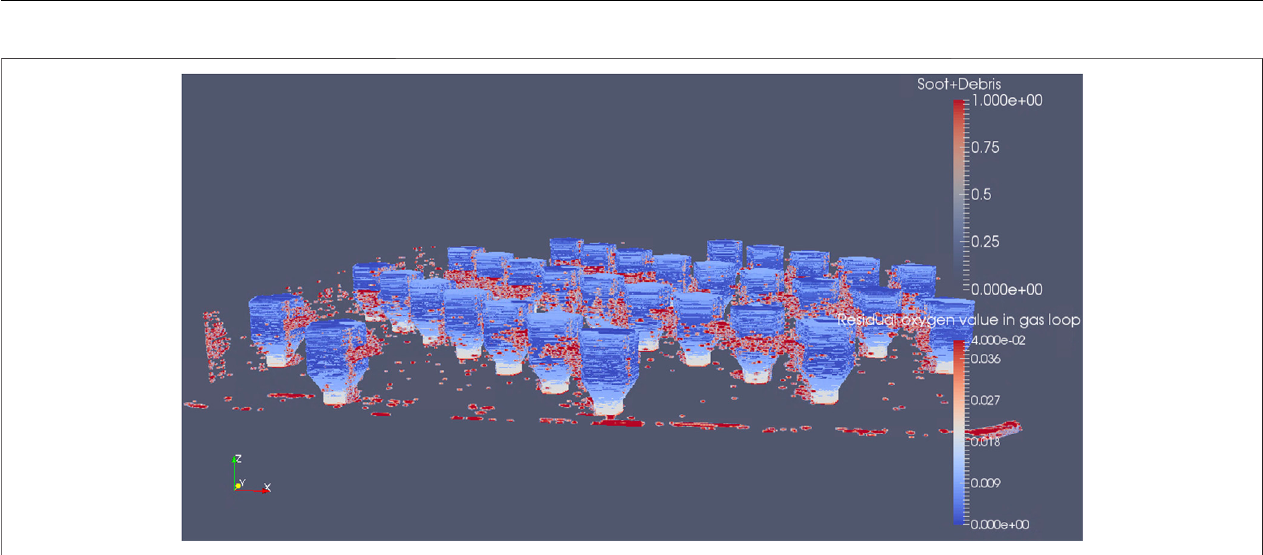
Frontiers in Mechanical Engineering |